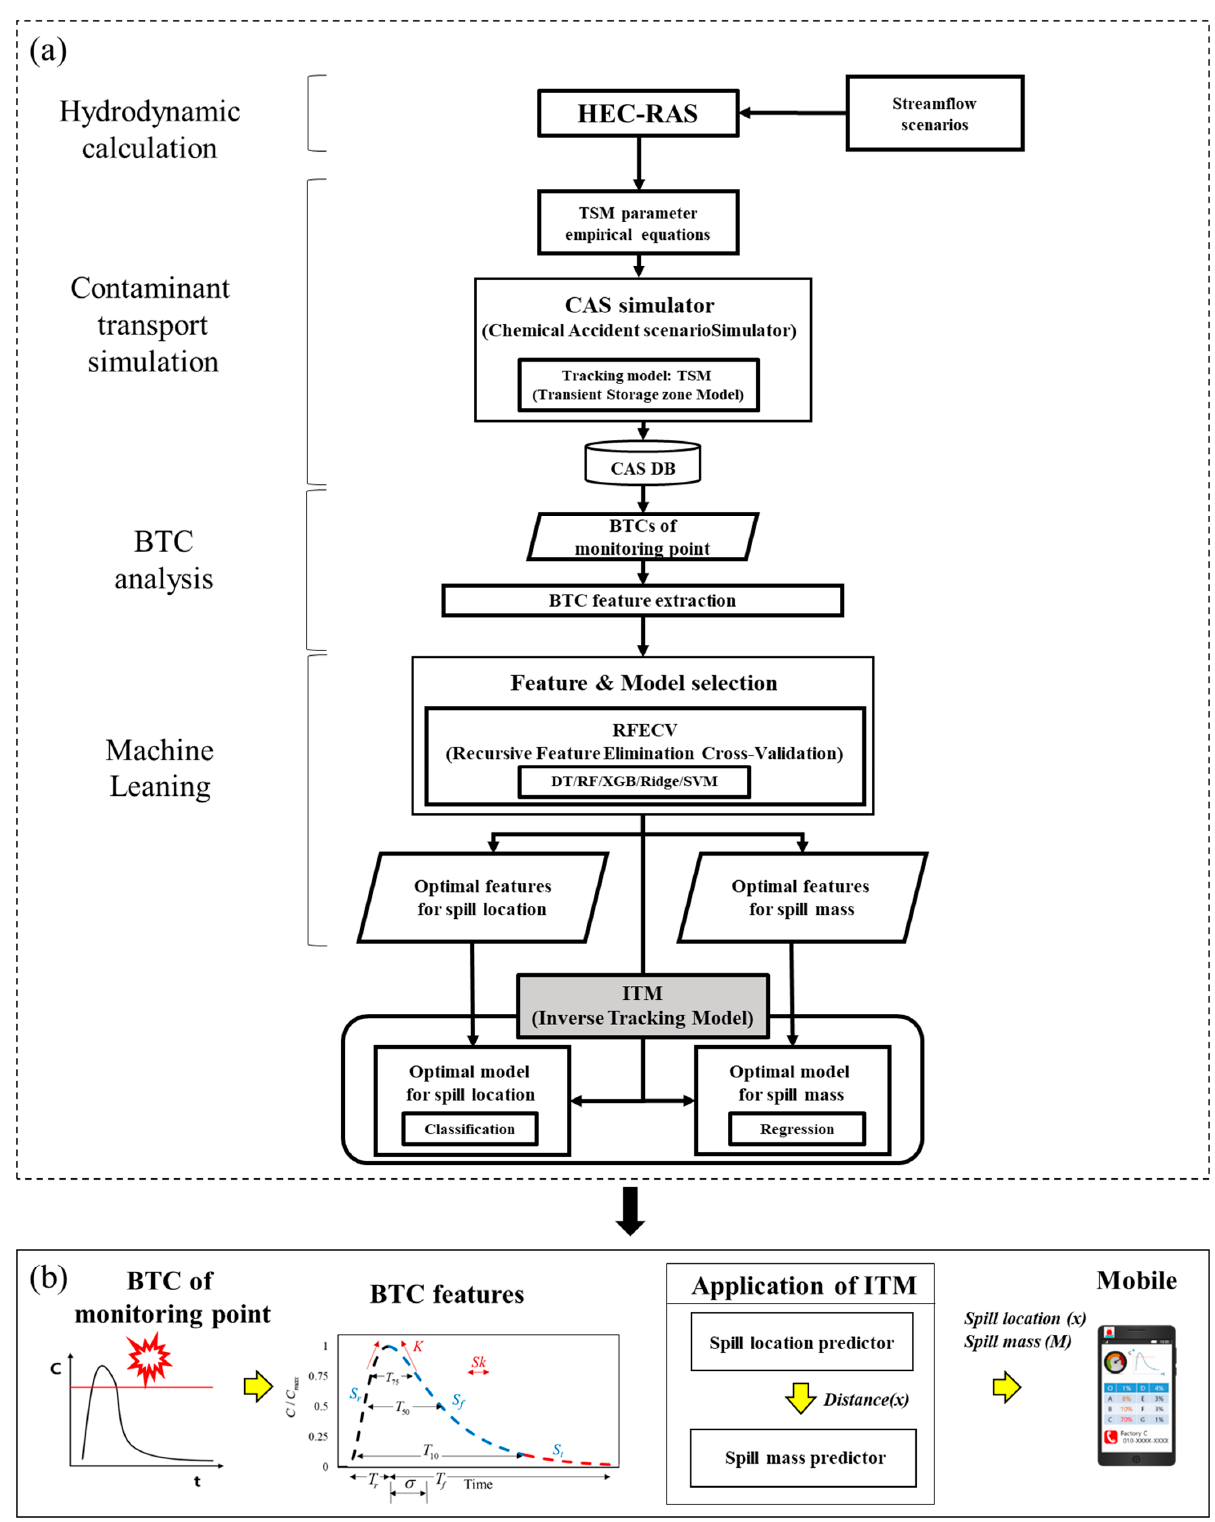
Figure 1. Schematic of the Inverse Tracking Model (ITM) framework: ( a ) development, and ( b ) application; HEC-RAS (Hydrologic Engineering Center’s River Analysis System) and TSM (Transient Storage Zone model) are hydrodynamic and contaminant transport model; CAS is Chemical Accident scenario Simulator; DB is Data Base; BTC is BreakThough Curve; DT is Decision Tree; RF is Random Forest; XGB is Xgboost; Ridge is Ridge regression model; SVM is Support Vector Machine.